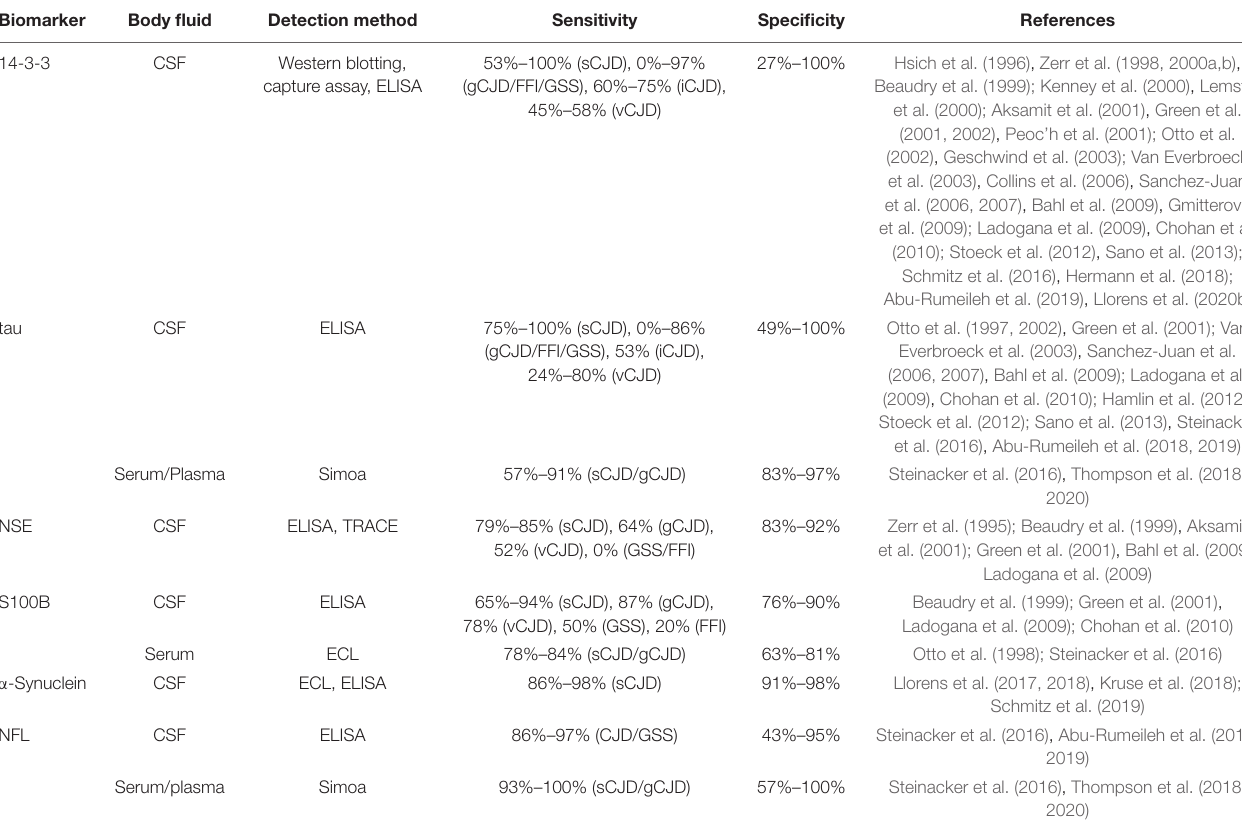
TABLE 4 | Surrogate biomarkers of prion